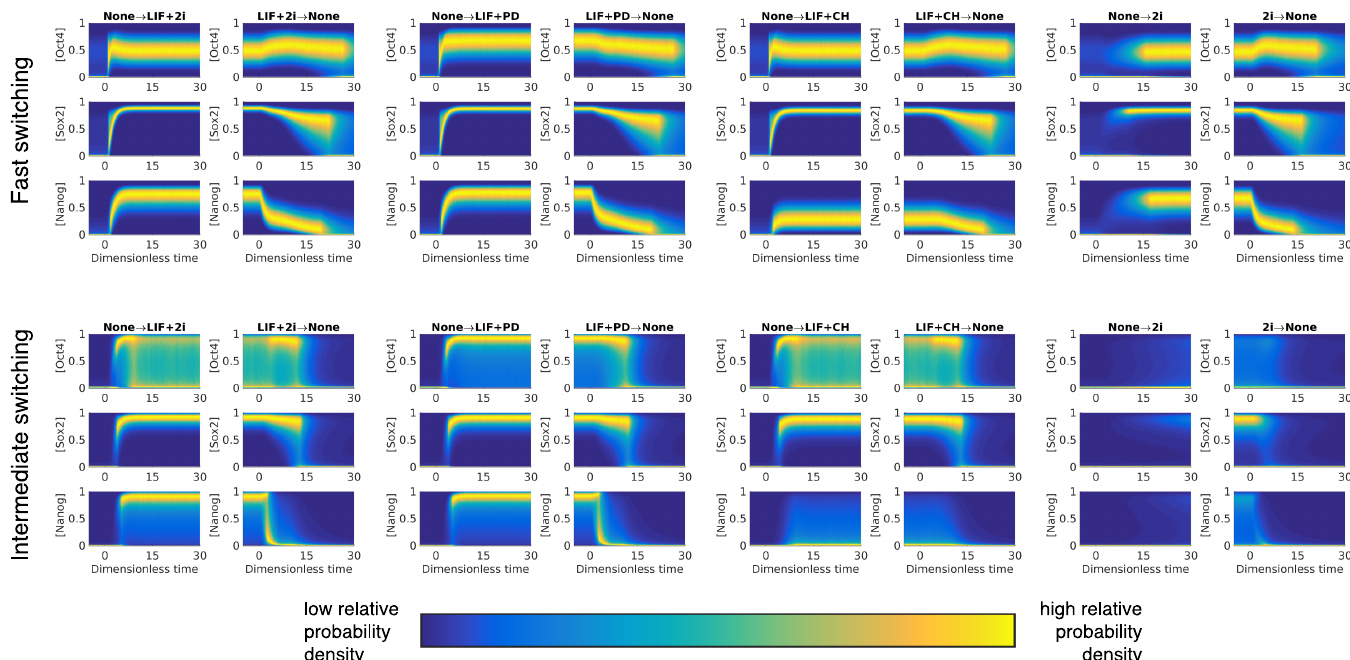
Fig 5. The dynamical behavior of the distributions of transcription factor densities for the intermediate and fast switching regimes. At time t = 0, the external inputs are changed. The plots show the evolution in probability density for a large ensemble (10 5 ) of PDMP sample paths. The times and populations are respectively rescaled by 1/ γ and α max / γ (see Method section). We assume the proteins are stable and so the their estimated half-life is of an order 8 hour [7]; in other words γ * 1/8 hr −1 , and the entire course of simulation ( t 2 (0, 30)) corresponds to physically 240 hours. A validation of the PDMP prediction by individual-based simulations can be found in S8 Fig in the Supporting Information.